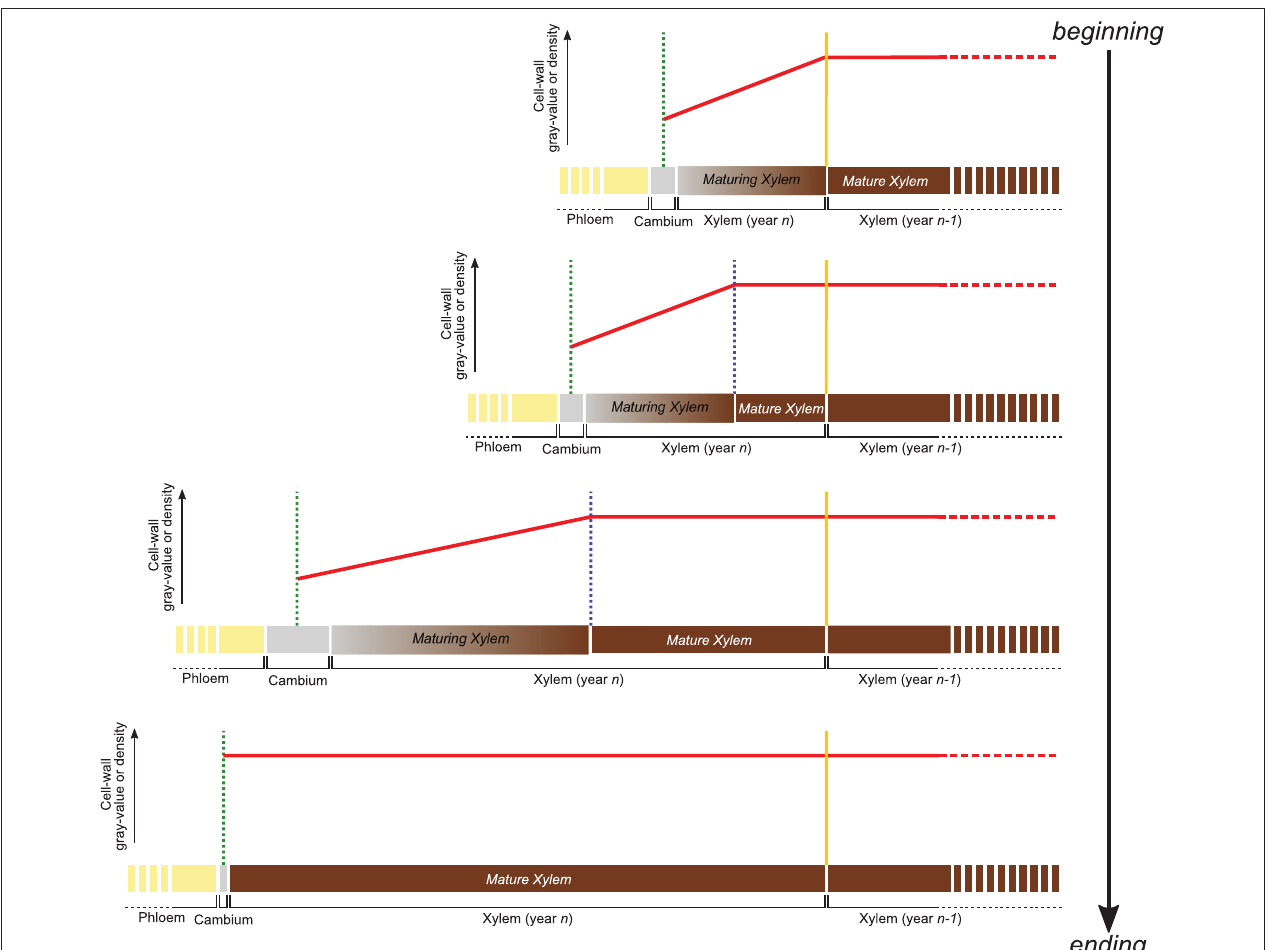
FIGURE 2 | Variation of cell wall gray value or density within the forming growth ring. Following cell wall maturation during xylogenesis, the cell wall density (red line) is expected to increase from the cambium (green dotted line) to the most recent mature xylem layer (blue dotted line). Within the mature xylem, the cell wall is fully developed and its basic density is assumed to be constant until the growth ring boundary (yellow dotted line) and beyond. The distance from the cambium at which the phase transition occurs, allows estimating the width of both mature and maturing